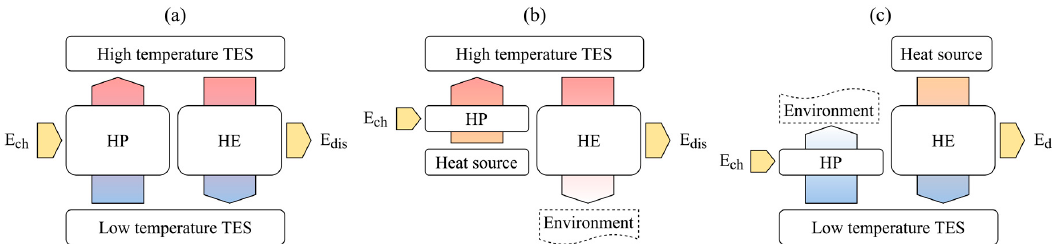
Figure 1. PTES working principle. ( a ) Standalone PTES. ( b ) TI-PTES with only the high-temperature reservoir. ( c ) TI-PTES with only the low-temperature reservoir. E ch is the electric energy charged in, whereas E dis is the electric energy discharged out.